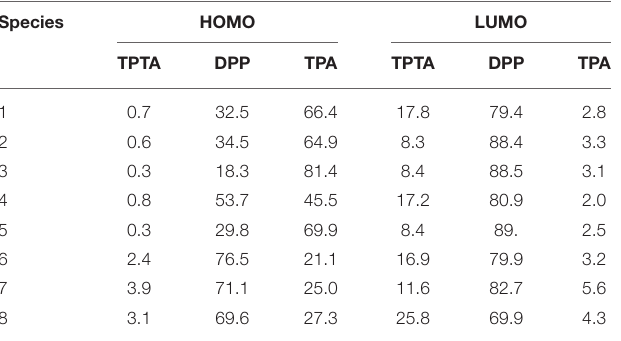
TABLE 1 | Molecular orbital contribution (%) from core TPTA, arms DPP, and end groups TPA to the FMOs of 1 – 8 at the PBE0/6-31G(d,p). Species